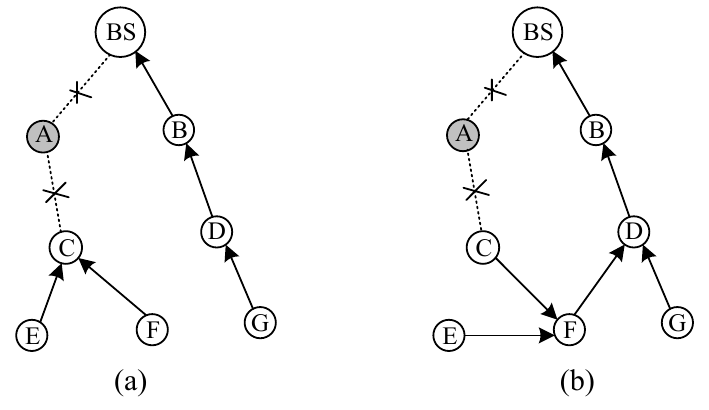
Figure 6. Parent node informs its children to trigger routing maintenance.